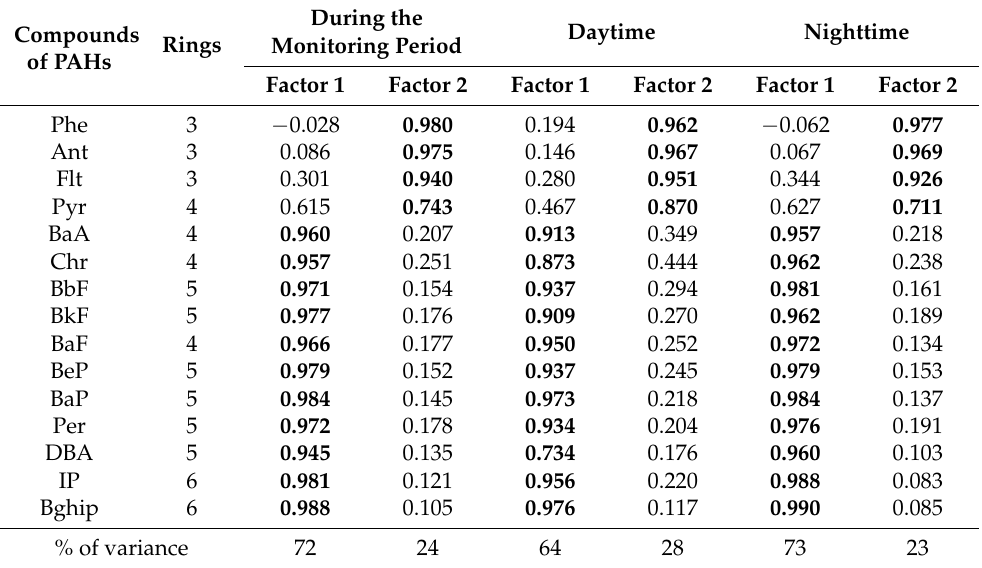
Table 4. Principal component analysis (PCA) results of PAHs in PM 2.5 in the study area during the monitoring